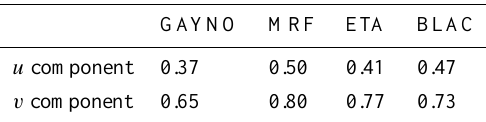
Table 3. Statistical comparison of the MM5 predictions using dif- ferent PBL parameterizations with wind profiler measurements in terms of correlation coefficients for the u and v components of the wind